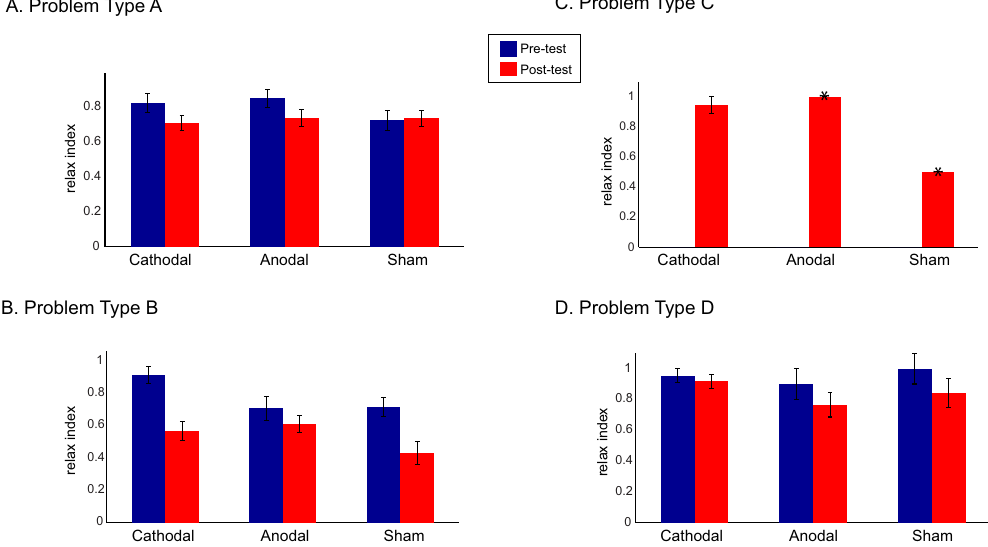
Figure 3. Relax index (as the percentage of time the problem was solved after having solved that problem once) before (blue) and after (red) cathodal, anodal and sham tDCS for problem types A, B, C, and D. Relax index is the proportion of correct solutions after the problem was solved for the first time. The error bars represent + / − 1 S.E.M. Note that for the problem type C there was only one participant in the post-test anodal and one in the sham conditions, which prevented the use of error bars ( *